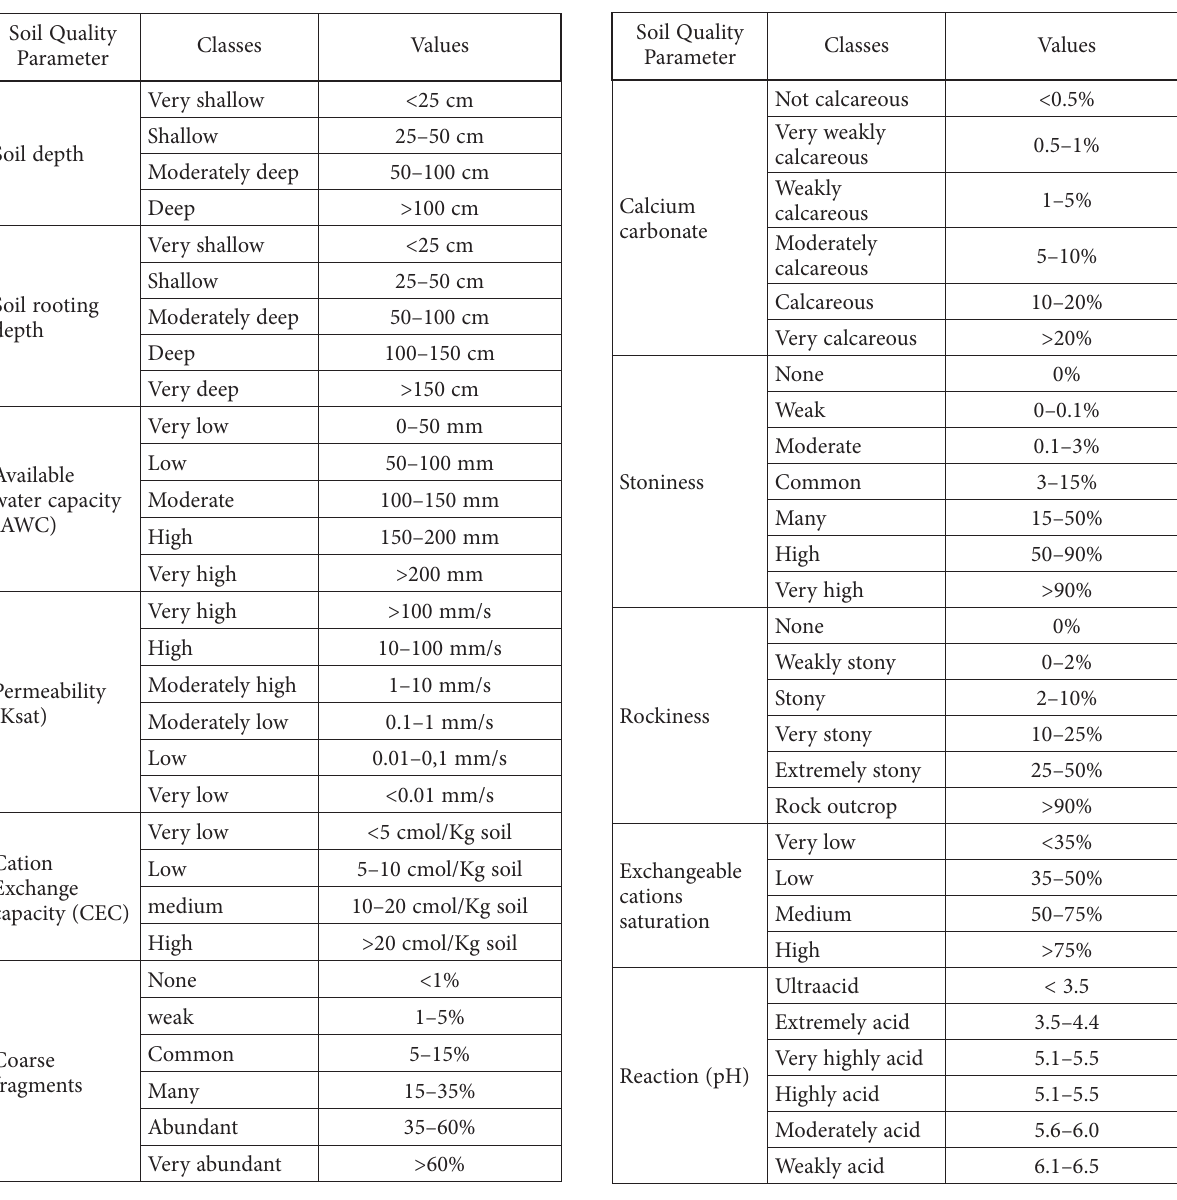
Table 2. The soil qualities parameters considered to describe the Soil Units are showing in the following